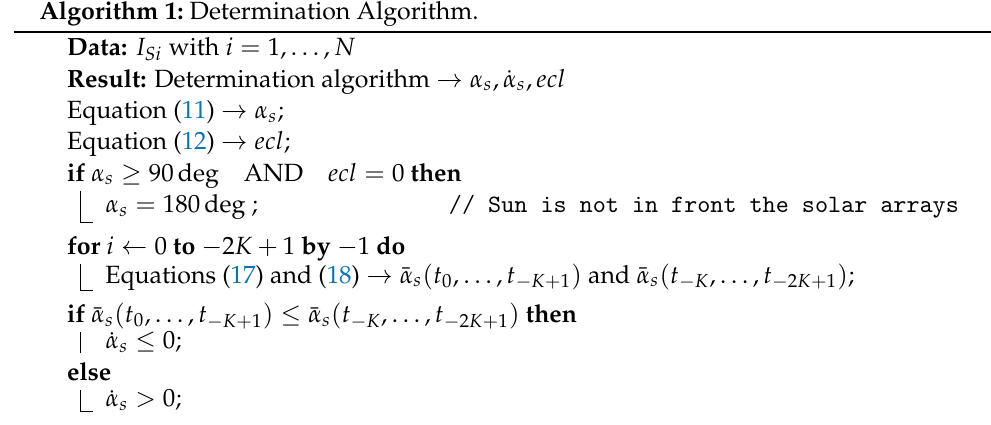
Algorithm 1: Determination